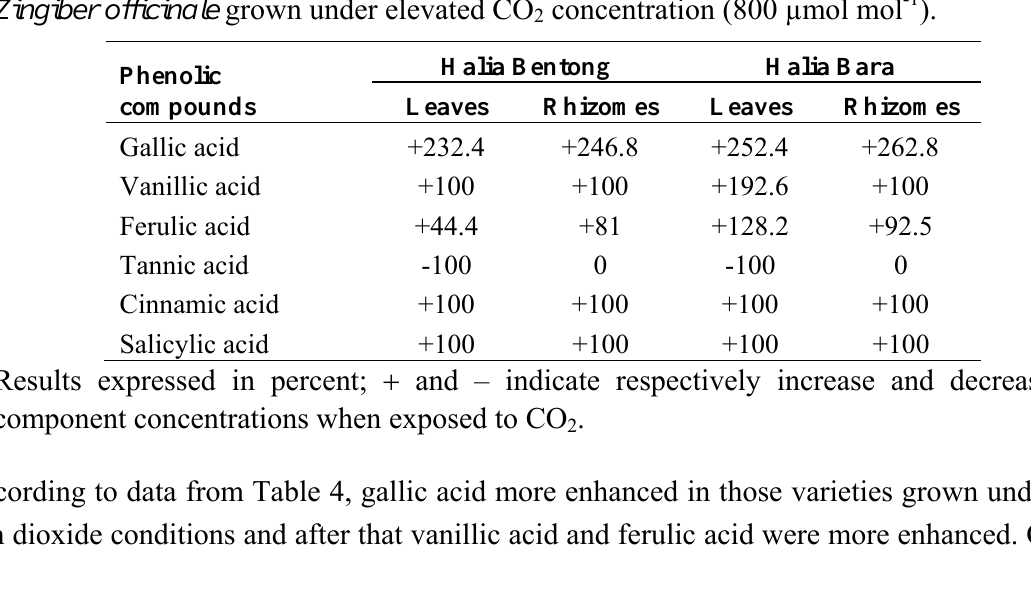
Table 4. Percent of increase or decrease of phenolic compounds in two varieties